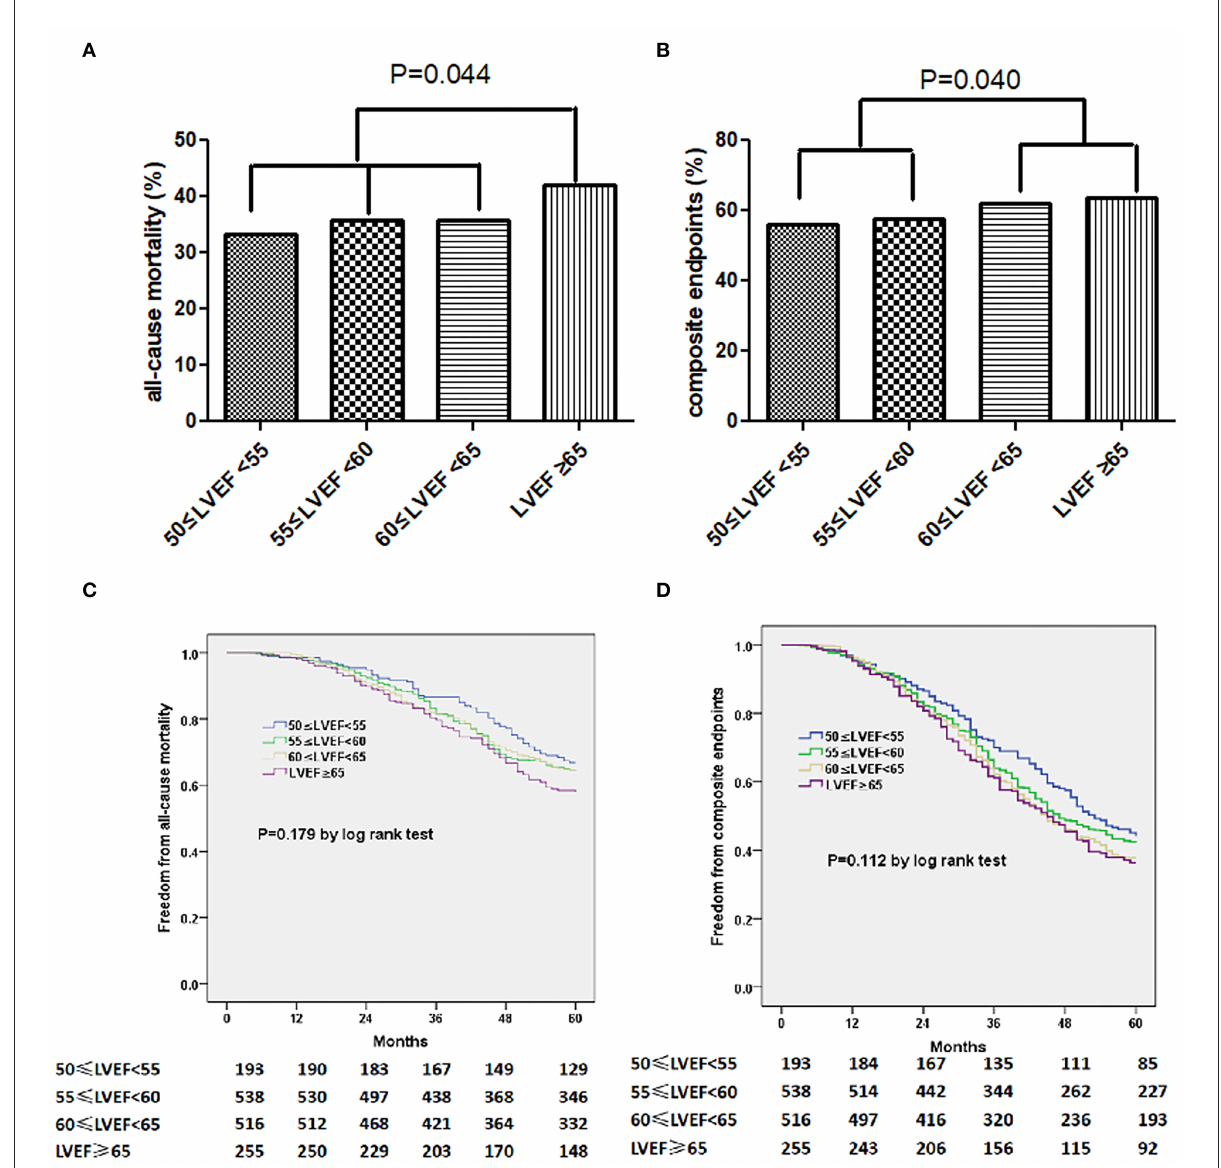
FIGURE1 The incidence of all-cause mortality (A) for composite endpoints (B) stratified by LVEF. Kaplan-Meier curves of freedom from all-cause mortality (C) or composite endpoints (D) varied by LVEF. The numbers at the bottom of the figure are “number at risk.”